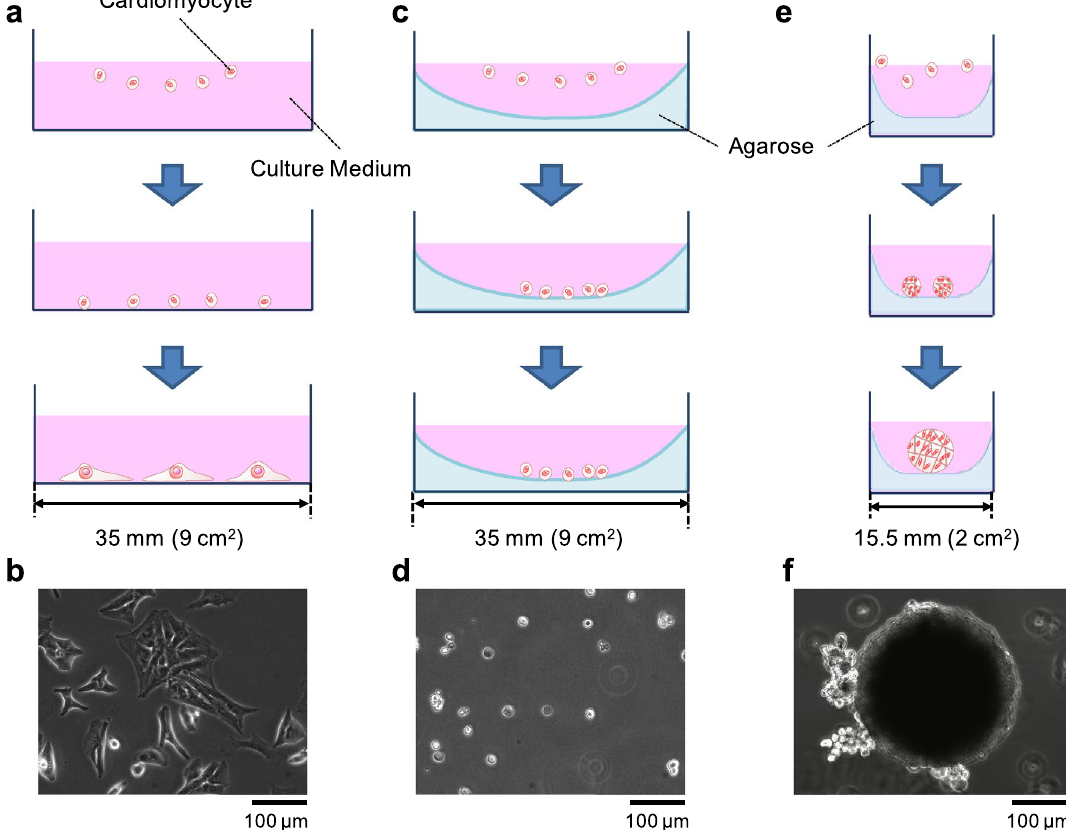
Figure 1. Formation of mouse primary cardiomyocyte clusters in agarose-coated wells. ( a ) Schematic drawing of the conventional dish cultivation of cardiomyocytes. The dispersed cells were cultured on the 4 cells / mL bottom of a 35-mm non-agarose-coated dish. After spread of the 2.0 mL of 5.0 × 10 isolated single cardiomyocytes, the cells attached on the bottom of the 35-mm cultivation dish dispersedly. The cells started to beat 2–3 days after cultivation started. ( b ) A micrograph of dispersed cardiomyocytes in a 35-mm non- agarose-coated dish. ( c ) Schematic drawing of the cultivation of dispersed cells in a 35-mm agarose-coated 4 cells / mL dish. After spread of the 2.0 mL of 5.0 × 10 isolated single cardiomyocytes, the cells dispersed on the bottom of the agarose layer in the agarose-coated 35-mm cultivation dish. Even after 2–3 days of cultivation, the cells remained isolated with a round shape, and no clusters formed on the bottom. ( d ) A micrograph of cardiomyocytes in an agarose-coated 35-mm cultivation dish. ( e ) Schematic drawing of the cultivation of dispersed cells in a 15.5-mm agarose-coated cultivation well (in a 24-well cultivation plate). After spread of the 4 cells/mL 1.0 mL of 5 × 10 isolated single cardiomyocytes, dispersed cells gathered and formed small clusters; finally, they gathered into a single large cluster in the 15.5-mm agarose-coated cultivation well. ( f ) A micrograph of a cardiomyocyte cluster in a 15.5-mm agarose-coated cultivation